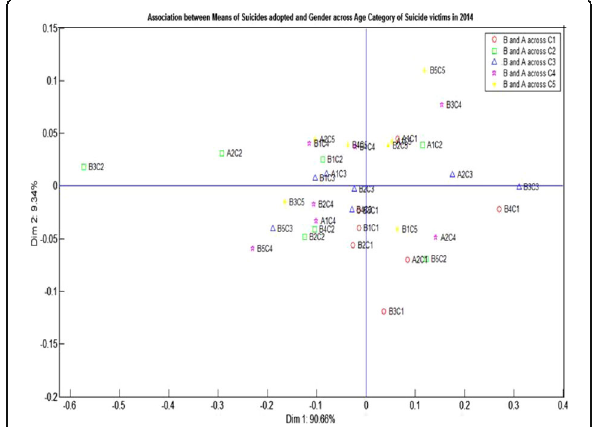
Fig. 13 Biplot showing association between (Means adapted for Suicides) and (Gender) across (Age